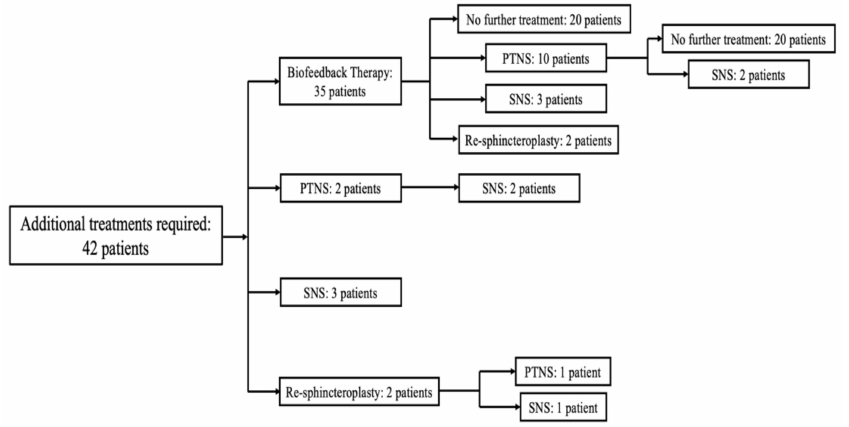
Figure 3. Flow-diagram of patients who needed additional treatments after initial sphincteroplasty. PTNS: Posterior tibial nerve stimulation; SNS: Sacral nerve stimulation.